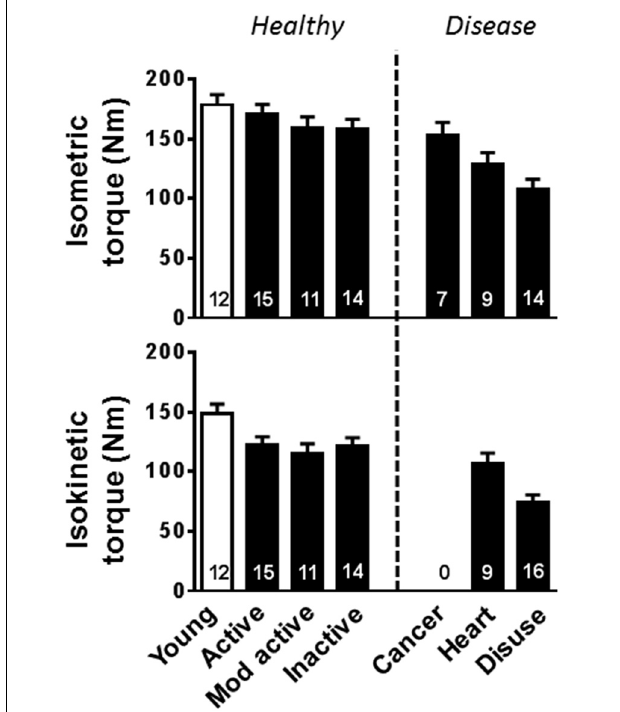
FIGURE 1 | Whole leg muscle contractile performance changes with aging, disease, and disuse. Young (open bars) and older (closed bars) are arranged such that whole muscle performance progressively decreases to the right along the x-axis. Volunteers identified as “Young” and “Mod active” are from Miller et al. (2013), “Active” and “Disuse” are from Callahan et al. (2014b), “Inactive” and “Heart” are from Toth et al. (2012), and “Cancer” are from Toth et al. (2013). Isokinetic torque measurements were collected at 60 ◦ /s. Mod, moderately; Heart, Heart